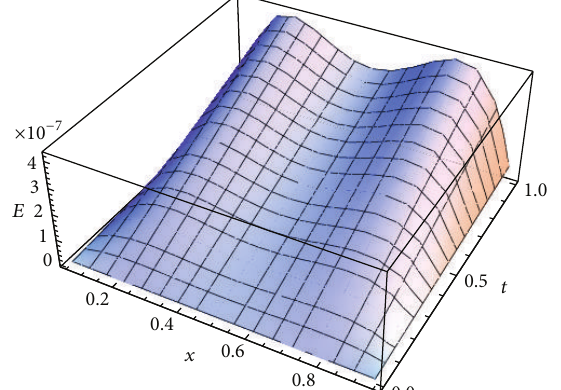
Figure 5: The absolute error of problem (40) where ] = 10 , 𝜇 = 0.1 , 𝑐 = 0.1 , −𝛼 = 𝛽 = 1/2 , and 𝑁 = 12 .